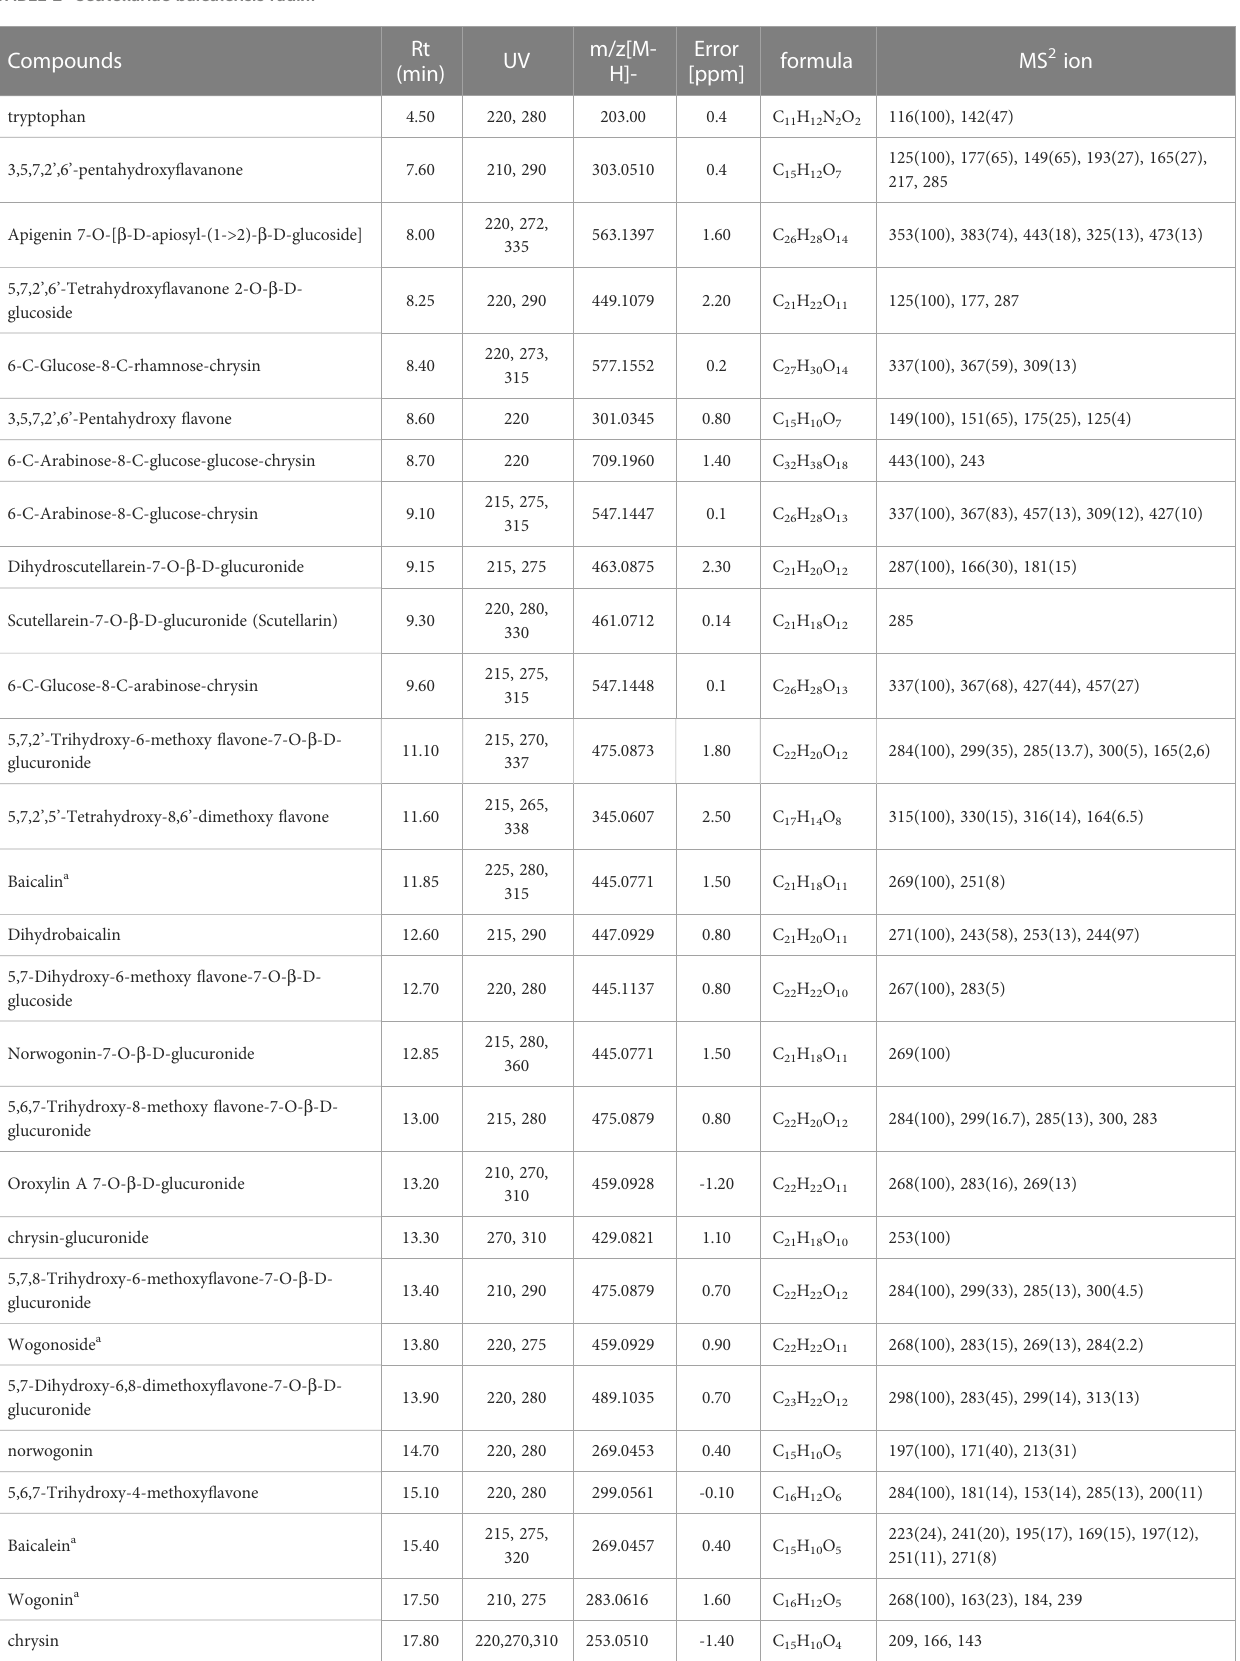
TABLE 2 Scutellariae baicalensis radix .